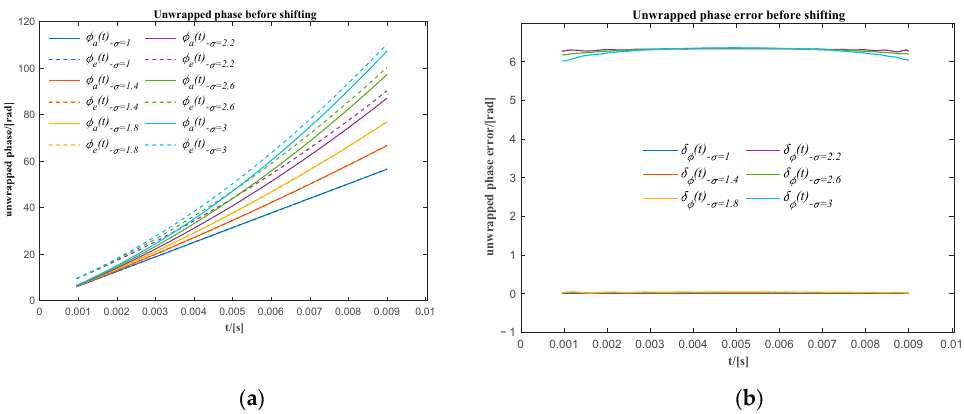
Figure 5. ( a ) The actual and the extracted unwrapped phase for different relative frequency ratios before phase shifting; ( b ) the phase error of the extracted unwrapped phase using the sum of the first two sub-signals before phase shifting.